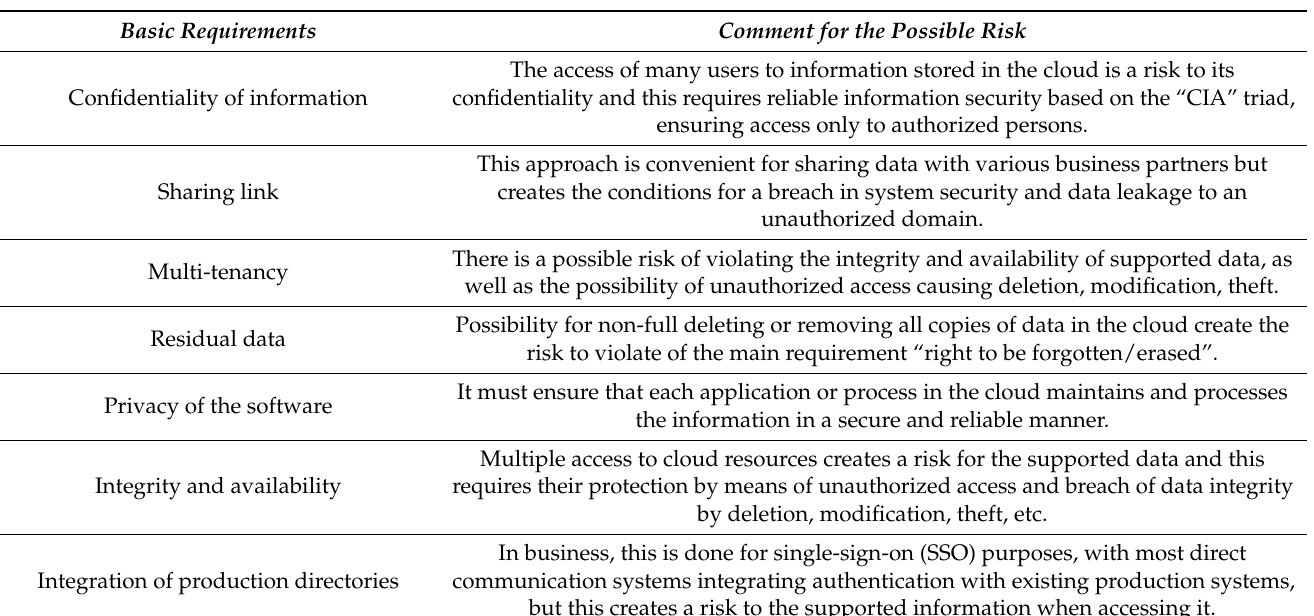
Table 1. Possible risks for data security in the cloud.